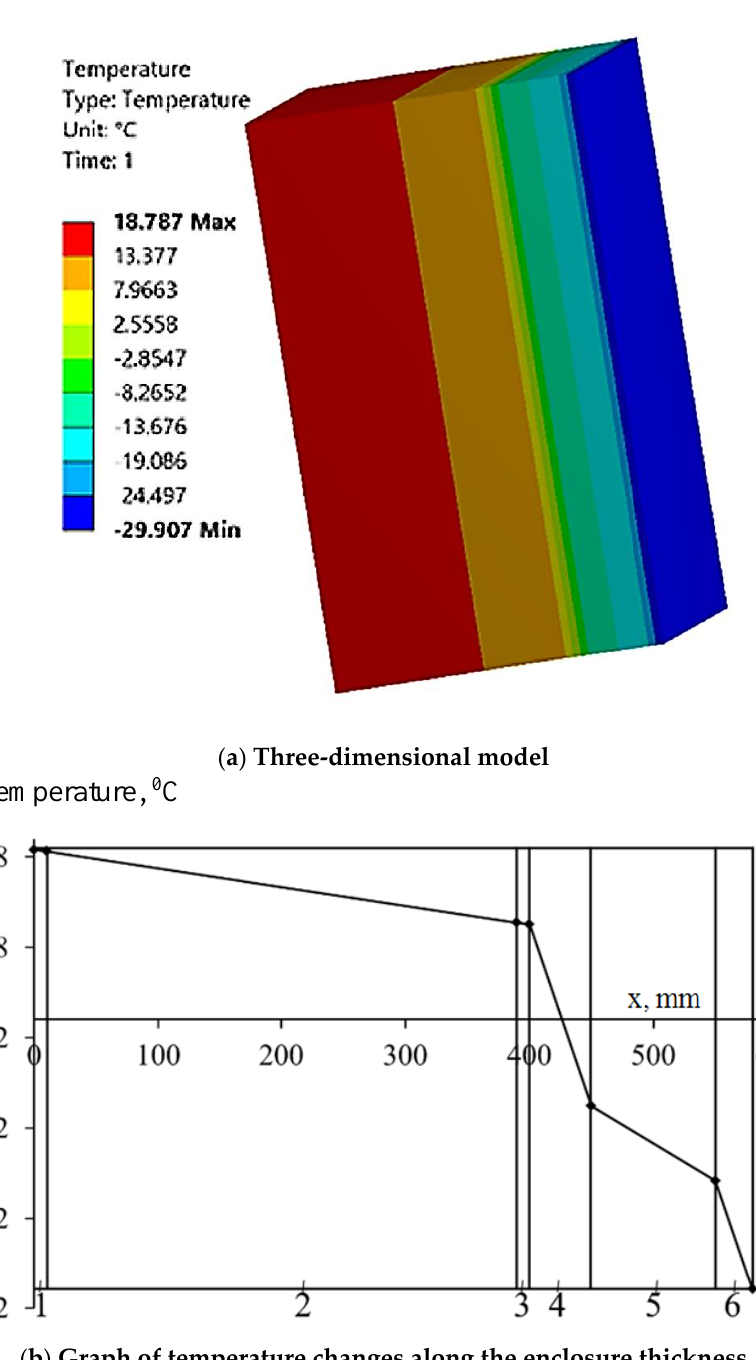
Figure 13. Temperature field in the enclosure at the absolute minimum ambient temperature: ( a ) — three-dimensional model; ( b ) — graph of temperature changes along the enclosure thickness: 1, 3 — cement-sand plaster; 2 — bearing layer from ceramic brick; 4 — insulant — extruded polystyrene foam; 5 — closed air gap.